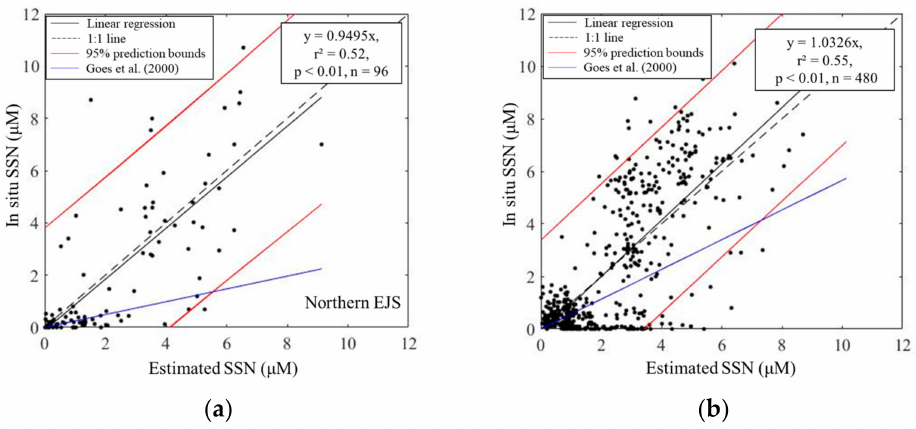
Figure 3. Correlations between field-measured Sea Surface Nitrate (SSN) and estimated SSN in the northern ( a ) and southern ( b ) East/Japan Sea. Dashed lines represent 1:1 lines. Red lines represent the 95% prediction bounds. Blue lines show the regression curves between in situ SSN and estimated SSN from the algorithm developed by Goes et al.